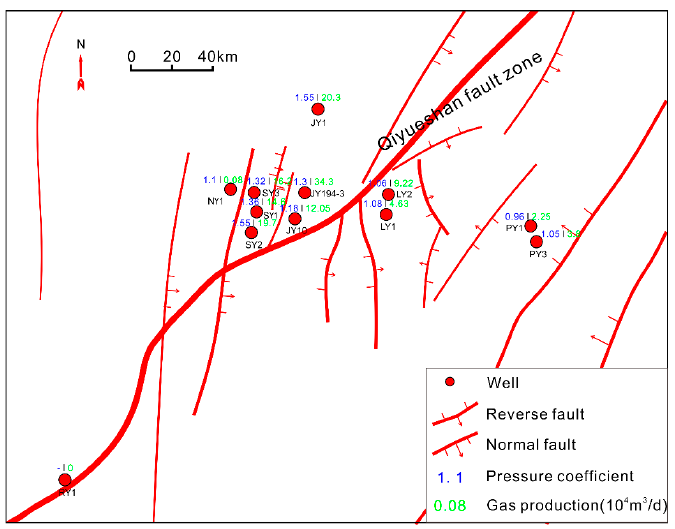
Figure 8. The plane relationship between production wells and large faults. It includes the actual daily output of each well and the pressure coefficient of high-quality shale formation. The preservation of natural gas is affected by structural factors such as the fold bend- ing degree of shale formation, fault shape, denudation intensity and structural style. Gen-